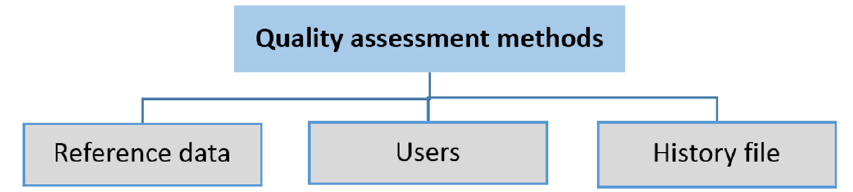
Figure 1. Categorization of VGI quality assessment methods.